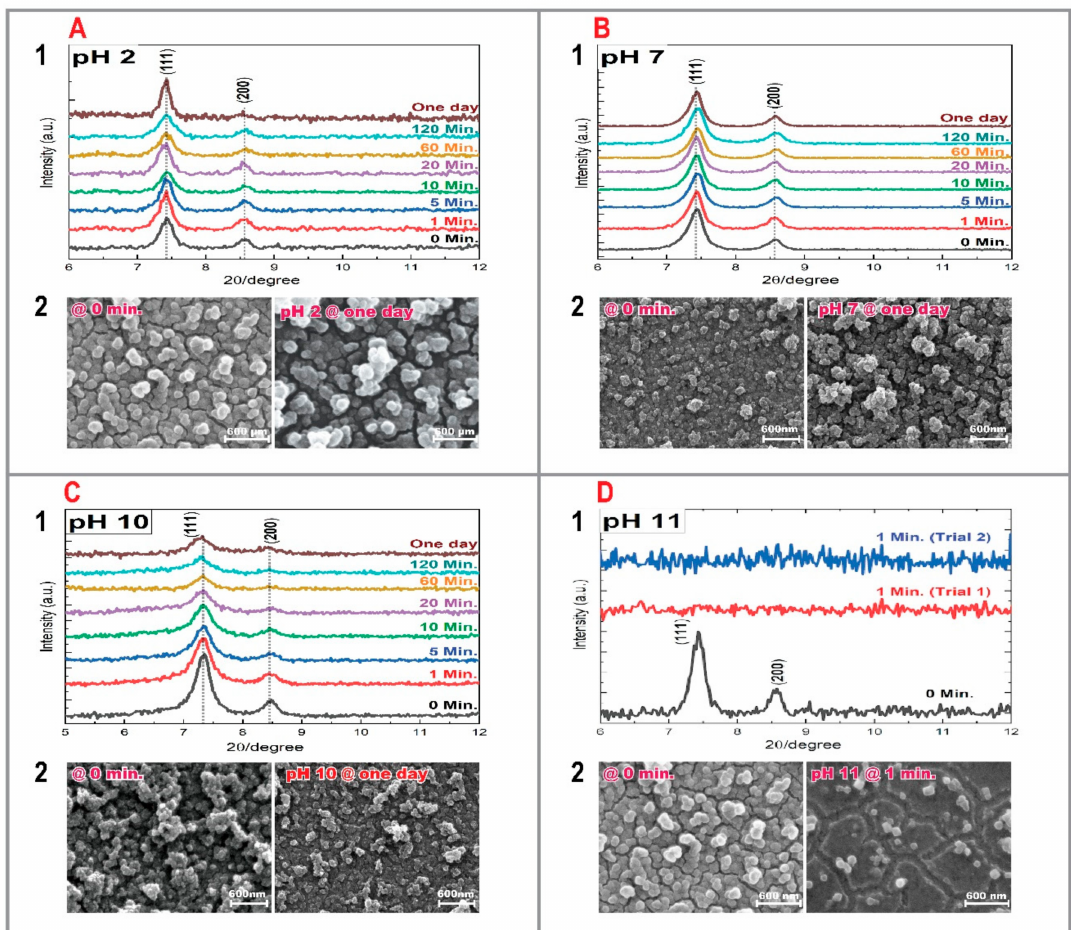
Figure 3. XRD patterns and SEM images of UiO-66-NH 2 SURMOF films immersed in a: ( A ) pH 2 solution, ( B ) pH 7 solution, ( C ) pH 10 solution, and ( D ) pH 11